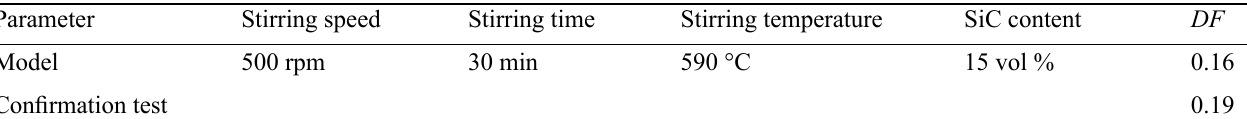
Table 6. DF at optimal conditions.